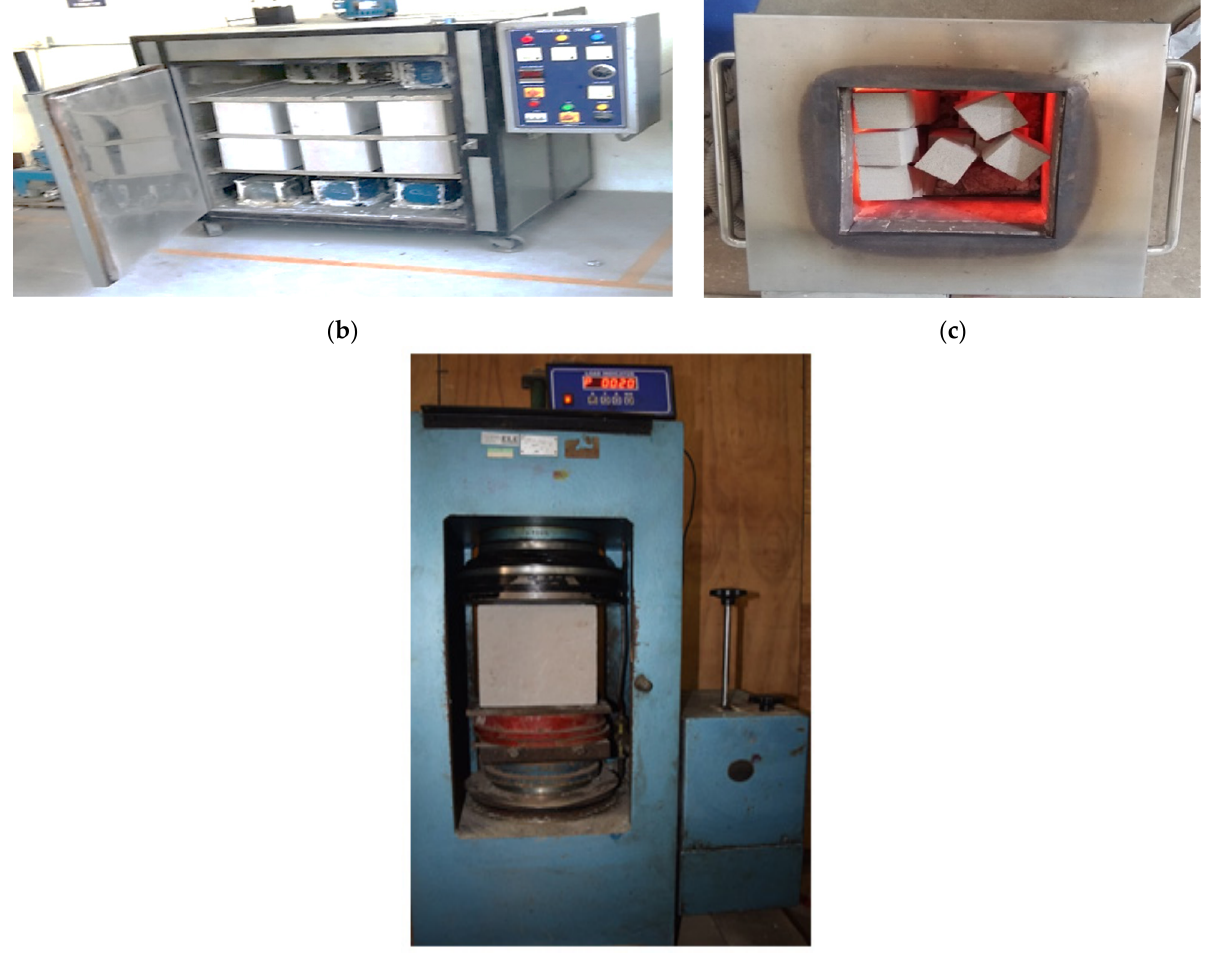
Table 2. Designation of specimens.